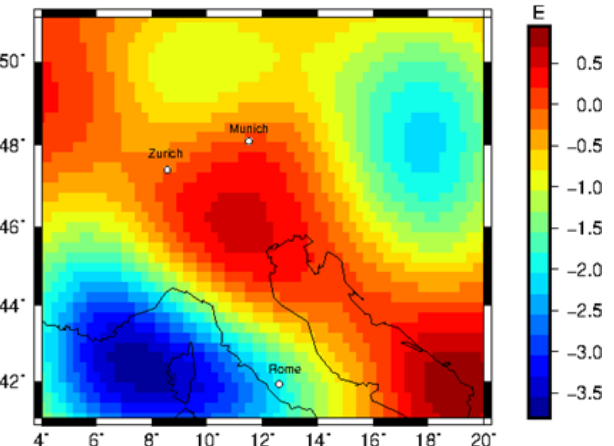
Figure A2. Forward-calculated gzz gravity signal from relative density distribution converted from relative seismic velocities using a con- version factor of 0.3 for the 225km station